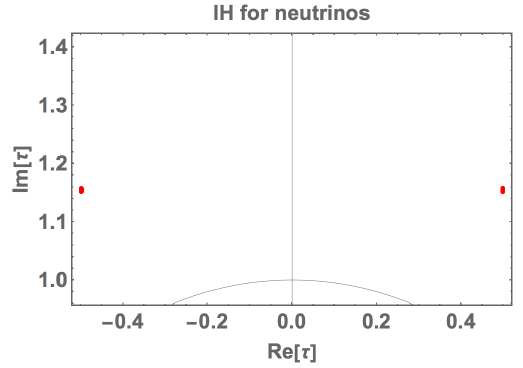
Figure 6 . Prediction of Dirac phase δ CP ver- sus Re [ τ ] for IH at